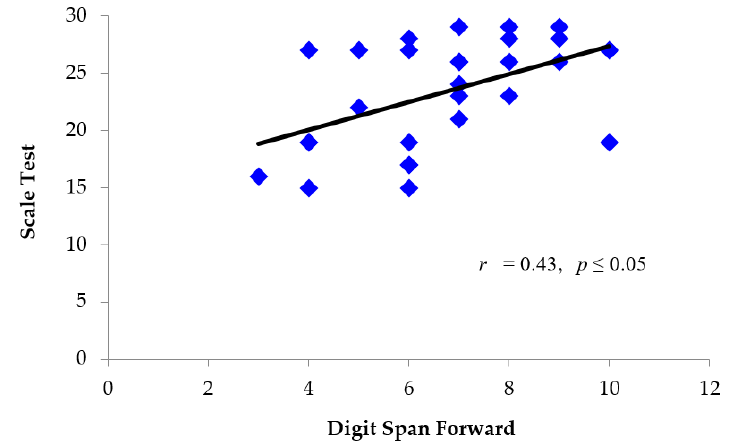
Figure 5. Individual scores for TBI patients depicting the relationship between performance on the MBEA Scale test (total score) and Digit Span Forward (scaled score). Patients who performed better on the Scale test also tended to perform better on Digit Span Forward.